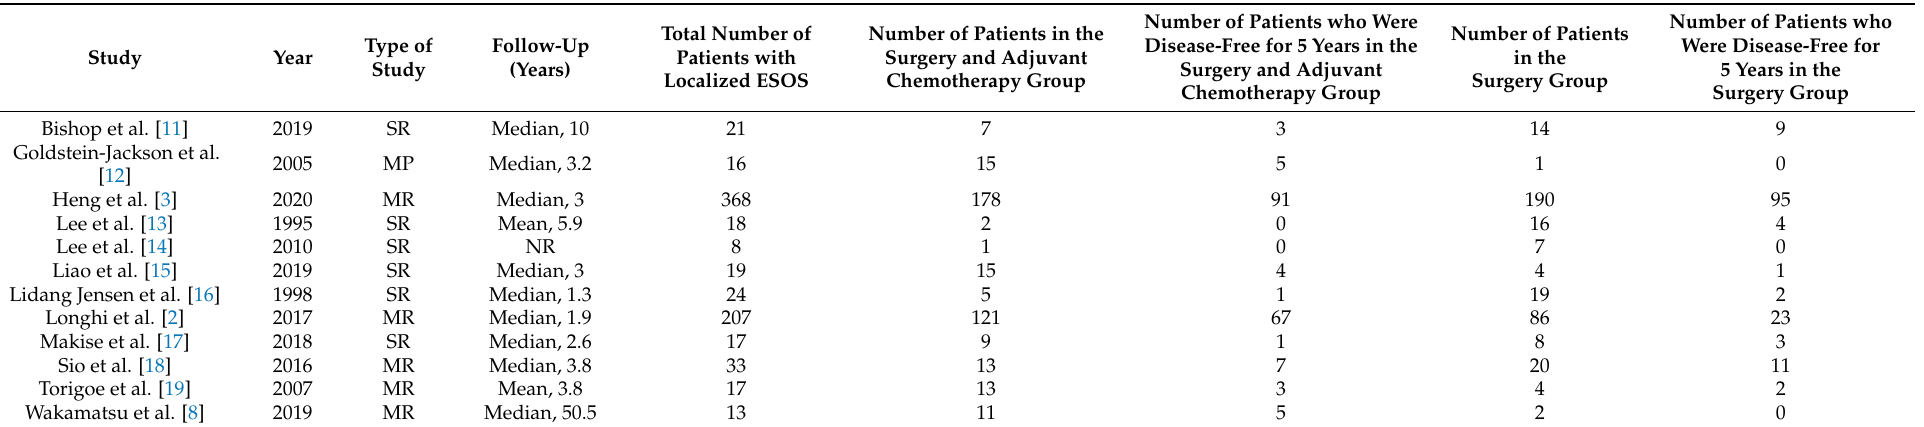
Table 1. Overall study